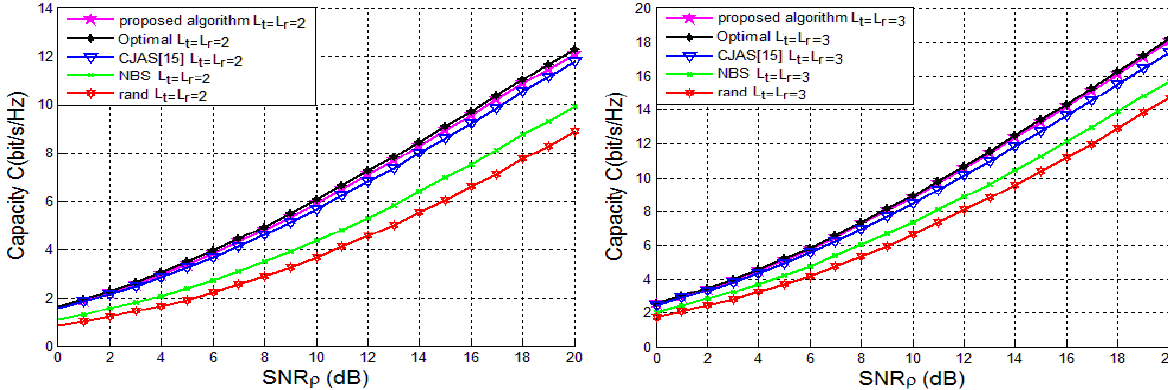
Fig. 7 statistical capacity versus SNR for { 7 , 3;7 , 3 } system